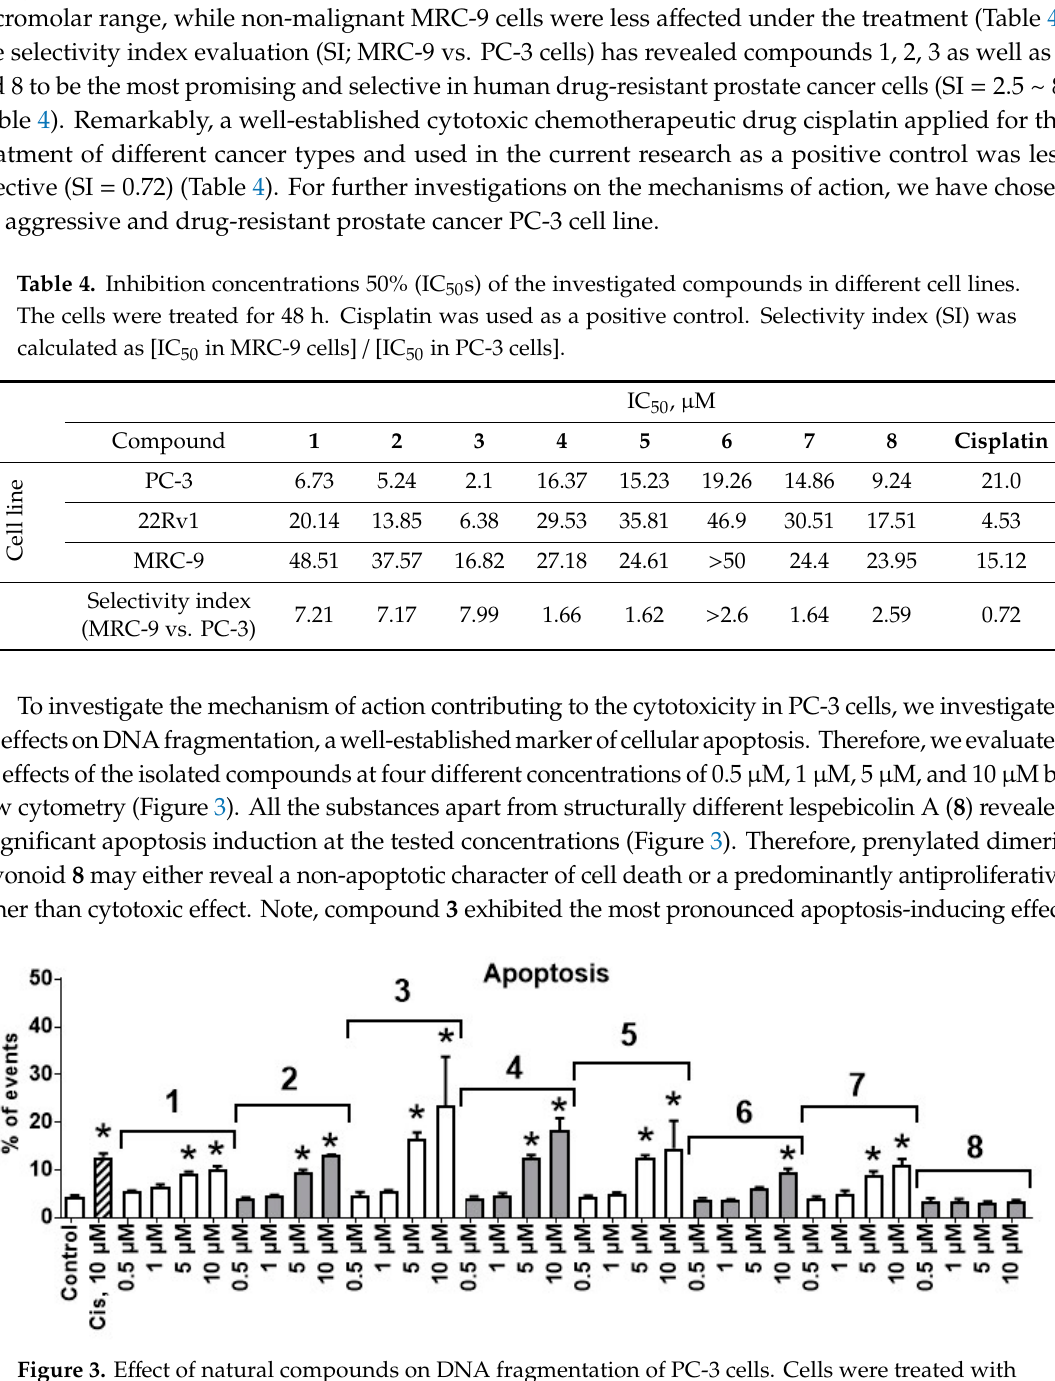
Table 4. Inhibition concentrations 50% (IC 50 s) of the investigated compounds in different cell lines. The cells were treated for 48 h. Cisplatin was used as a positive control. Selectivity index (SI) was calculated as [IC 50 in MRC-9 cells] / [IC 50 in PC-3 cells].